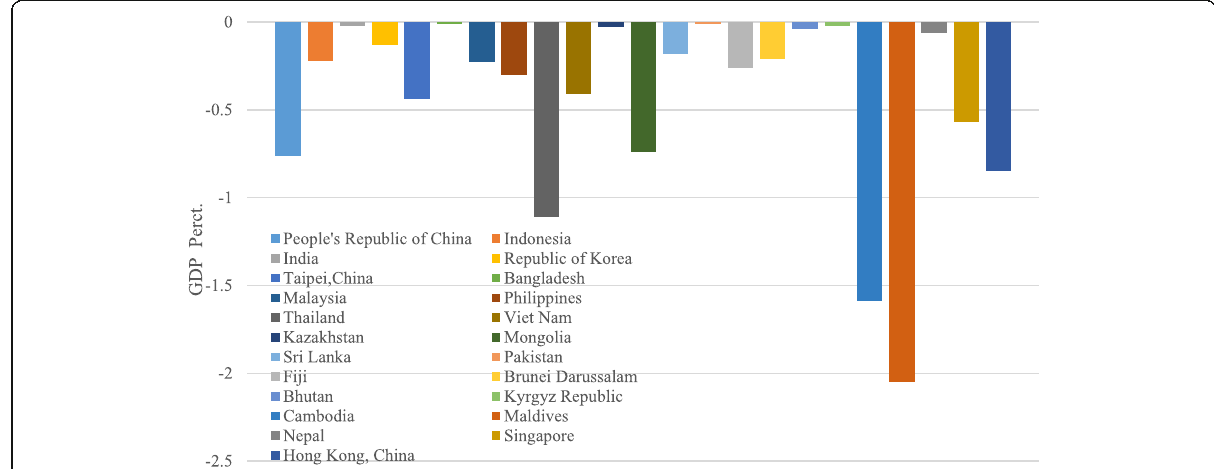
Fig. 4 The economic impact of the COVID-19 outbreak on developing Asia (March